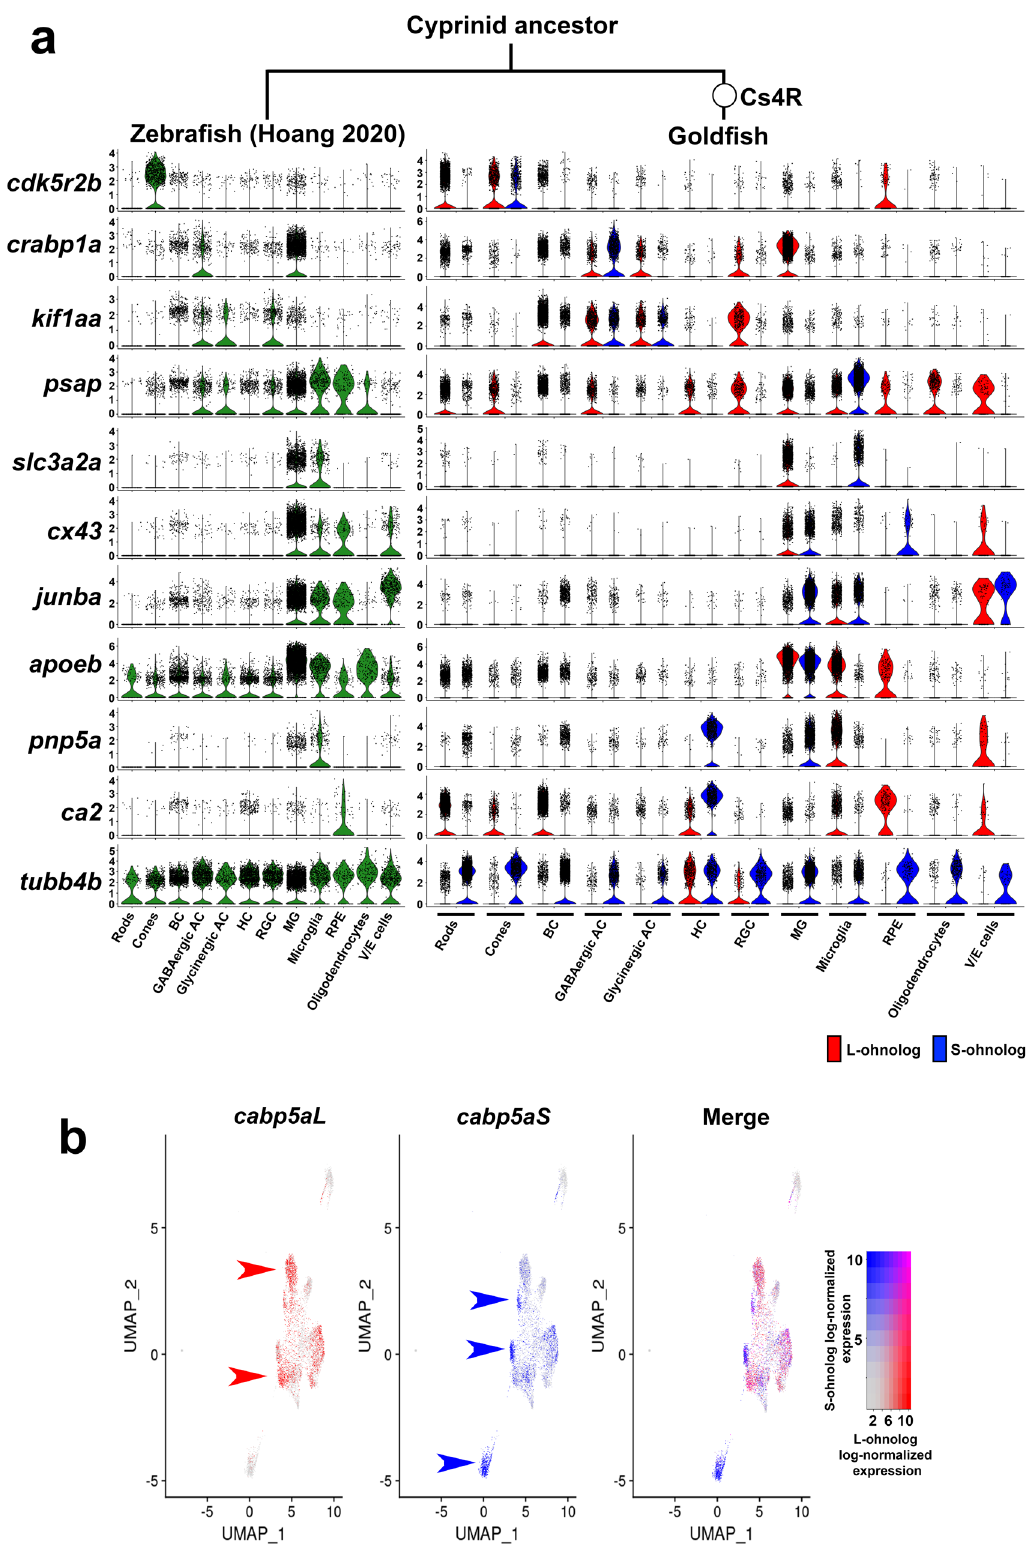
Fig. 5 Ohnolog pairs in which the L-ohnolog and S-ohnolog show different expression pro fi les. a Violin plots showing the gene expression of ohnolog pairs in which the L-ohnolog (red) and S-ohnolog (blue) exhibit different expression pro fi les. The scRNA-seq data of the zebra fi sh retina 42 are shown on the left, for reference. b The cabp5a ohnologs exhibit a diversi fi ed expression pattern in the bipolar cells of the UMAP cluster. The red or blue arrowheads indicate the enriched cells expressing cabp5aL or cabp5aS ,